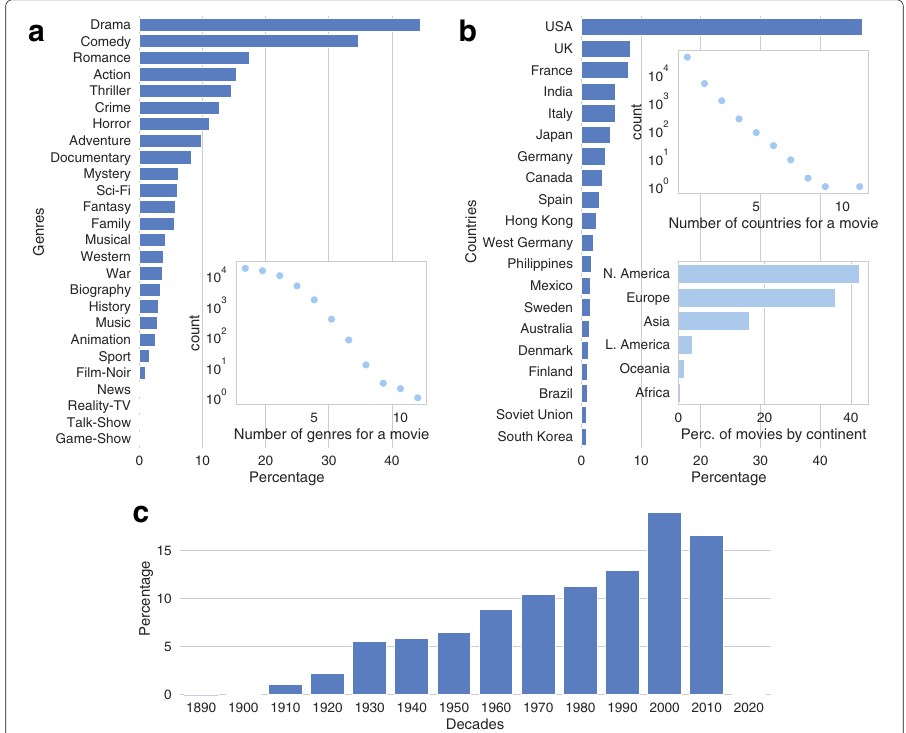
Fig. 1 Percentage of movies by genre, country of production and year of first release. a Genres, b Countries, c Years of first release, grouped by